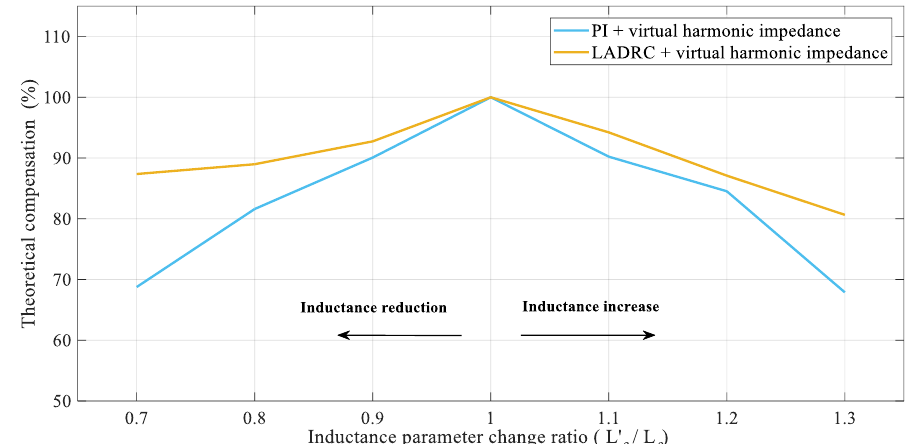
Figure 9. The relationship between theoretical compensation degree and parameter variation.